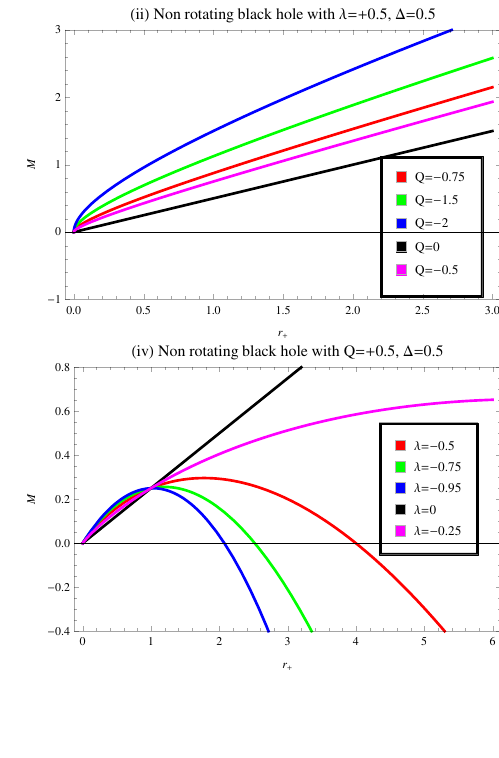
mass function that appears in these plots is converging to a specific amount of M at r + ≈ 1.